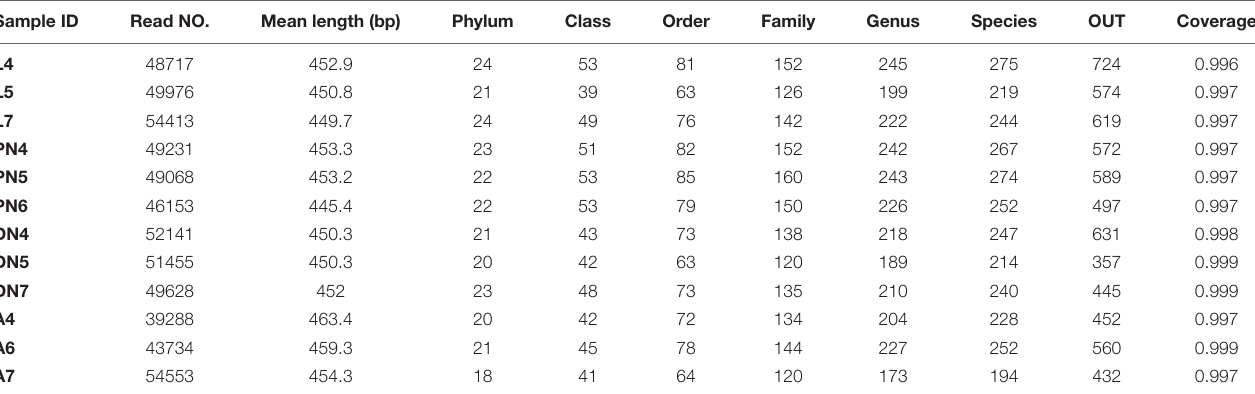
TABLE 1 | Summary of the 16S rRNA read counts of endo-bacteria across the life stages of P. citri *. Sample ID Read NO. Mean length